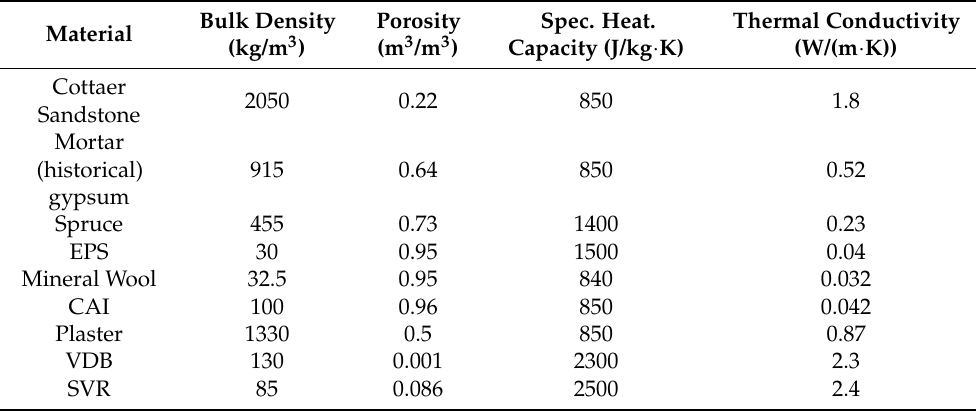
Figure 8. Hygrothermal properties of the employed materials: ( A ) moisture storage function, ( B ) water vapor diffusion, ( C ) liquid transport coefficient. Table 1. Basic material data used for the developed model.